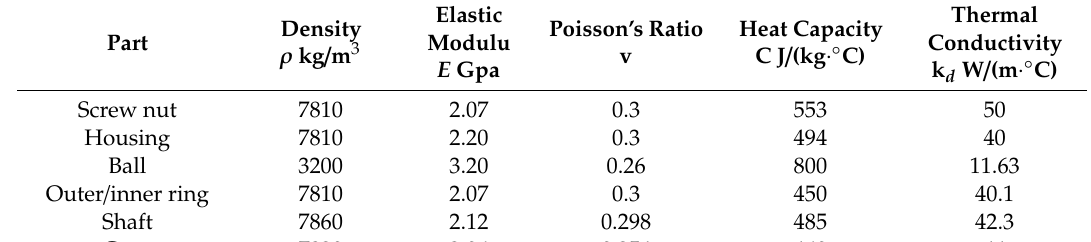
Figure 1. Experimental setup for measuring thermal characteristics. ( a ) Experimental equipment; ( b ) thermal sensor location.